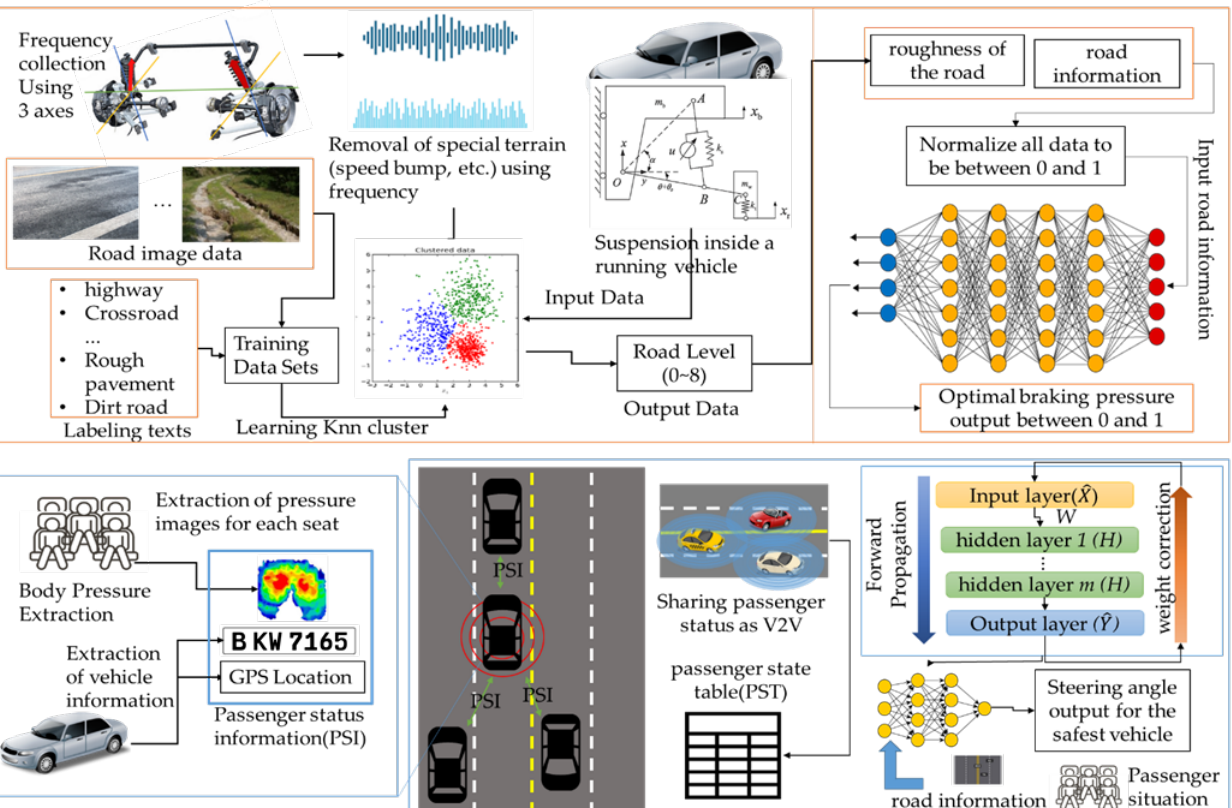
Figure 1. The structure of a BDDS.